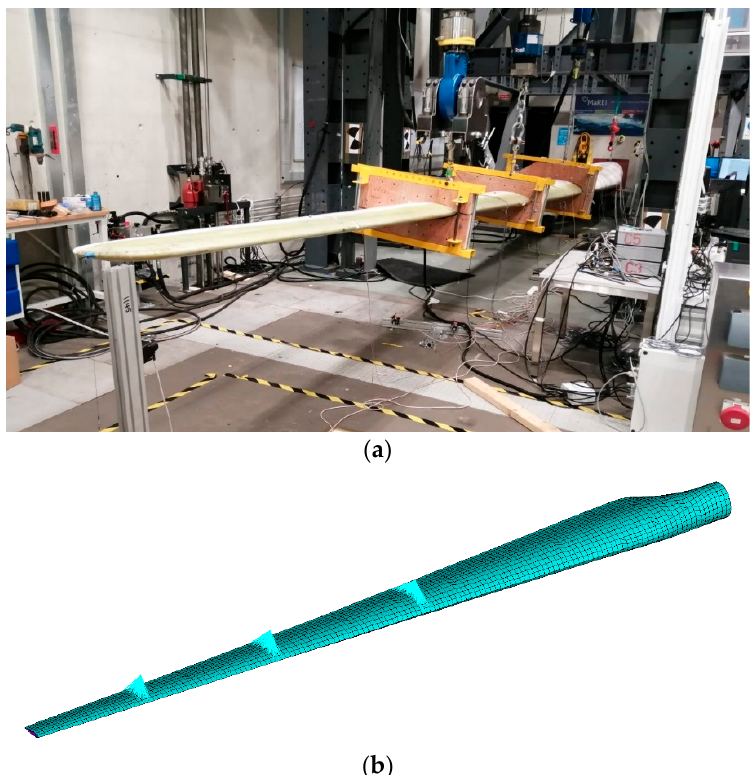
Figure 8. ( a ) Test setup of the reference wind turbine blade; ( b ) FE model of the reference wind turbine blade.